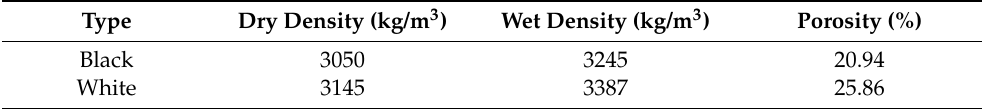
Table 1. Density and porosity of the SMS samples.